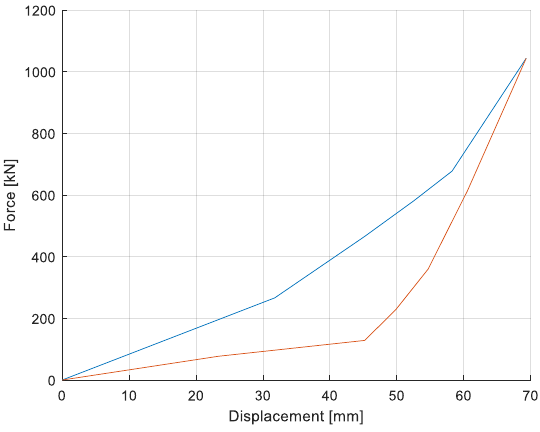
Figure 17. Rubber buffer model.